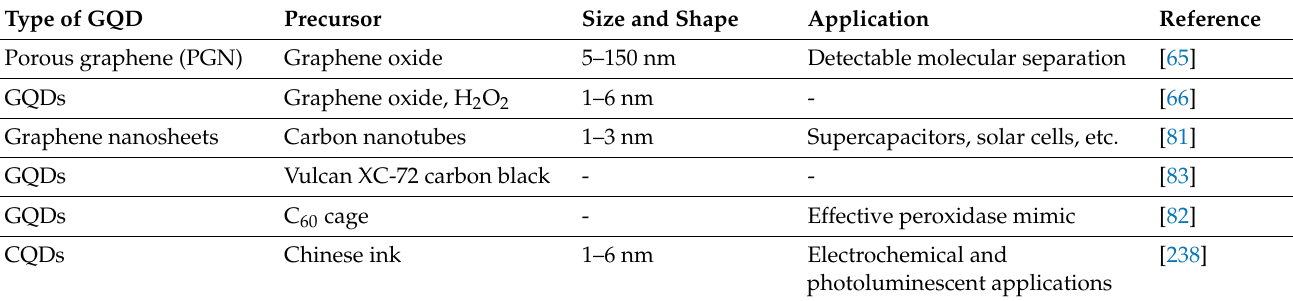
Table 8. The oxidation (free-radical, chemical, etc.) methods for the preparation of